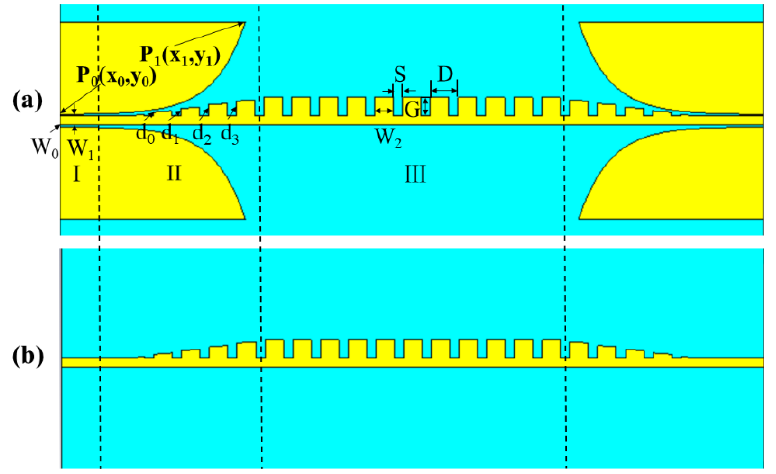
Figure 2. Momentum and impendence transition from coplanar waveguide (CPW) to double-layered spoof surface plasmon polariton waveguide. ( a ) Top view. ( b ) Bottom view.